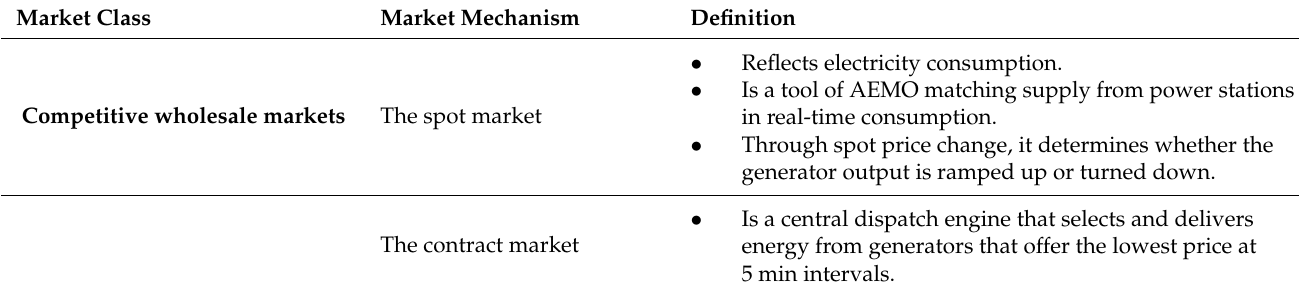
Table 3. Summary of the Australian National Electricity Market (NEM)